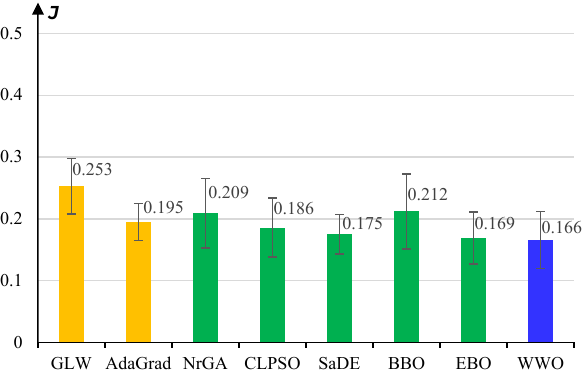
Figure 3. Average reconstruction errors and standard deviations of the comparative algorithms for pretraining the lower common layers of the Behavior Learner .